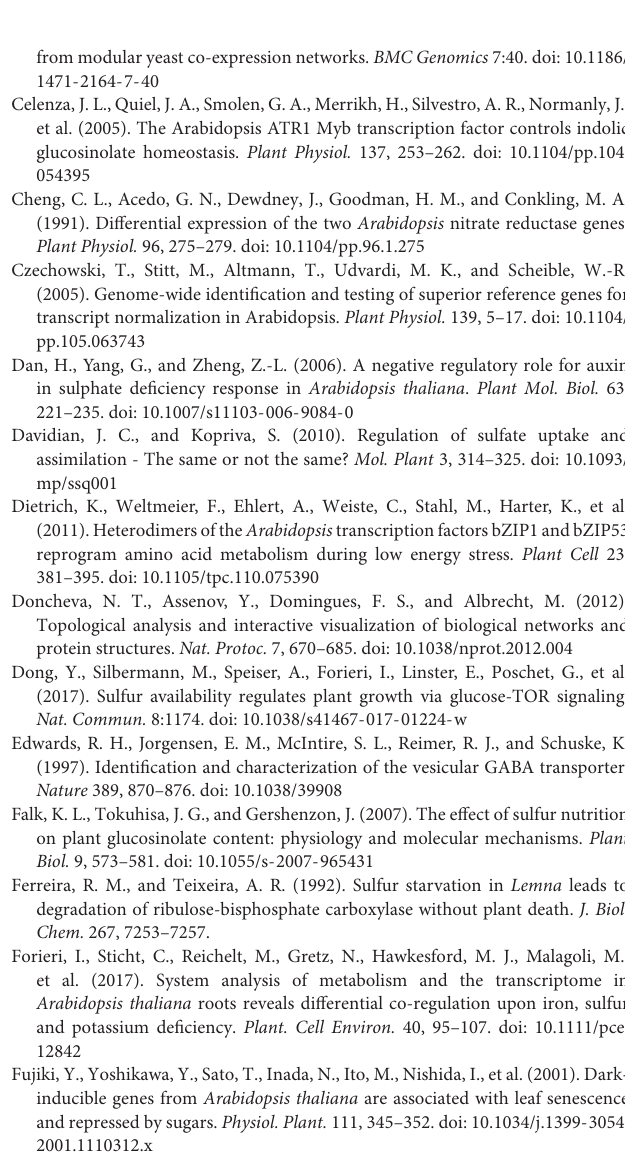
differentially expressed in at least two different experiments in a previous study (Canales et al., 2014) or in the present study. FIGURE S3 | Selection of the Pearson’s correlation threshold for the construction of the sulfate co-expression network. FIGURE S4 | Overlap between genes and GO terms in our meta-analysis and the pioneering microarray experiments of Hirai et al. (2003), Nikiforova et al. (2003), and Maruyama-Nakashita et al. (2006). TABLE S1 | List of oligonucleotides used for qPCR analyses. TABLE S2 | List of sulfate-responsive genes ranked according to their consistency in the sulfate response. TABLE S3 | List of genes involved in the sulfate co-expression network ranked according to their number of connections. TABLE S4 | Gene Expression Omnibus accession numbers and descriptions of the samples included in Figure 4B